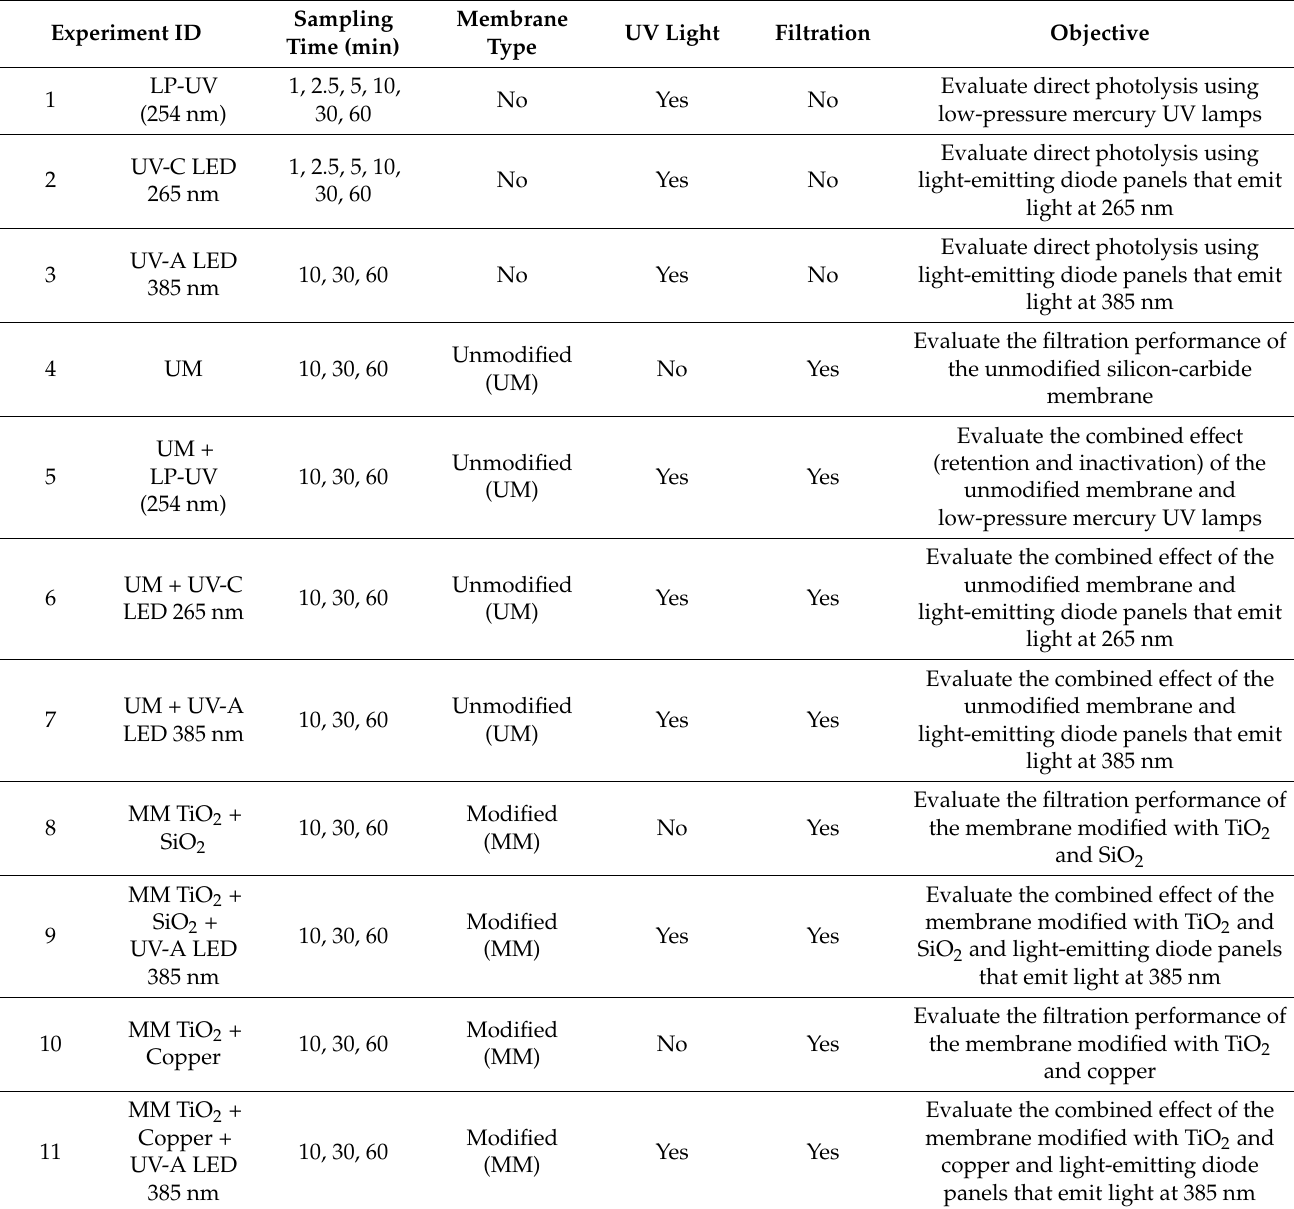
Table 2. Description of the eleven experiments performed in the submerged hybrid